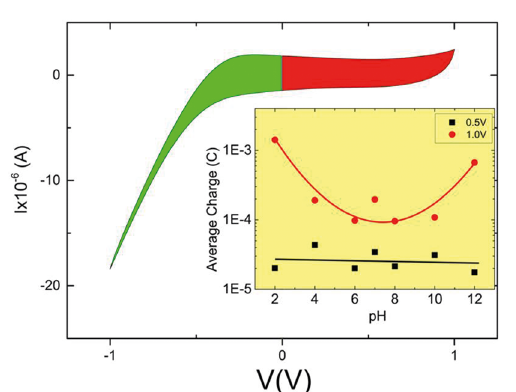
Figure 6. Typical cycle provided by cyclic voltammetry for a FTO sample. For this graphic a sample of 10Ω/sq was used. No offset voltage was applied to the sample. Inset) Results from the cyclic voltammetry experiments. Average of charges accumulated at the sample’ surface for different pHs and different voltages applied to the film. The maximum error for 0.5V is ± 3.9E-5C and for 1.0V ±